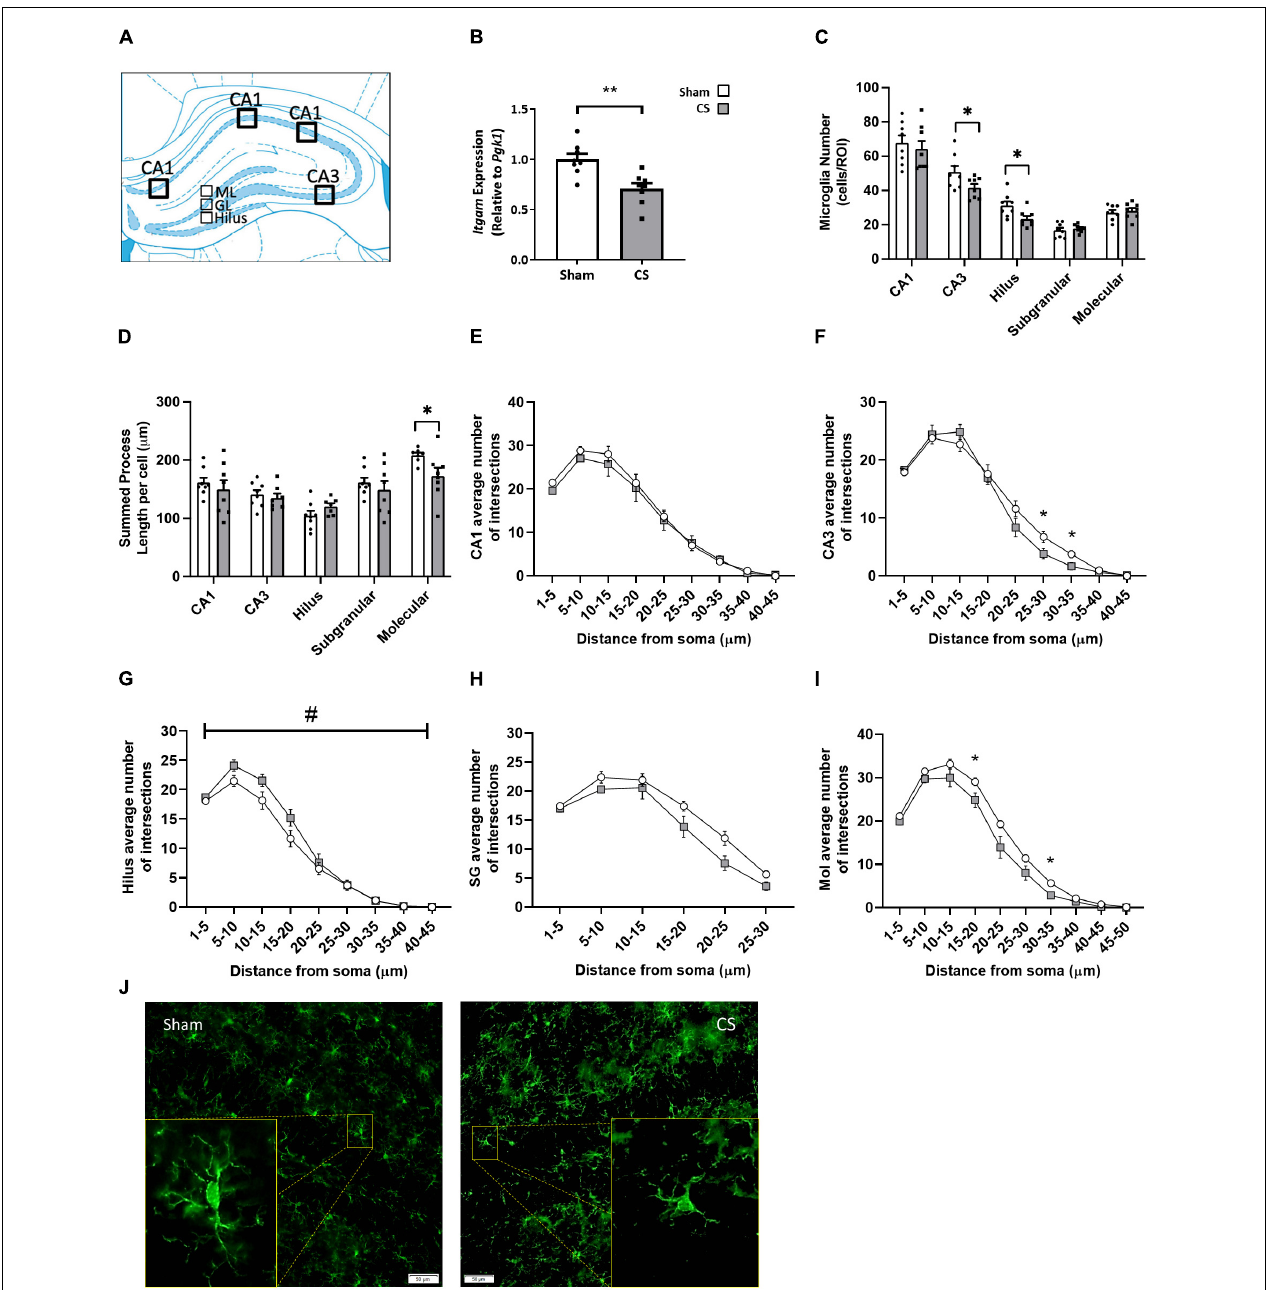
FIGURE 6 | Chronic CS exposure decreased microglial numbers and increased microglial activation in the hippocampus. (A) Schematic diagram of the mouse hippocampus where regions of interest were analyzed. (B) Inflammation in the mouse hippocampi was assessed by qPCR. (C) Microglial (ionized calcium-binding adapter molecule 1 [Iba-1]-positive) numbers in the CA1, CA3, and the dentate gyrus [hilus, subgranular (SG), and molecular regions]. (D) Overall length of microglial processes in all regions of the hippocampus. (E–I) Sholl analysis of microglia in all regions of the hippocampus. (J) Representative images of Iba-1 analysis in the mouse hippocampus. qPCR and microglial number data were analyzed by Student’s t -test and expressed as mean + SEM with significance being represented as; * p < 0.05, ** p < 0.01. Sholl analysis data was analyzed via repeated measures and expressed as mean ± SEM with significance being represented as * p < 0.05. The symbol “#” represents interaction between both independent variables when p < 0.05. n = 7–8.